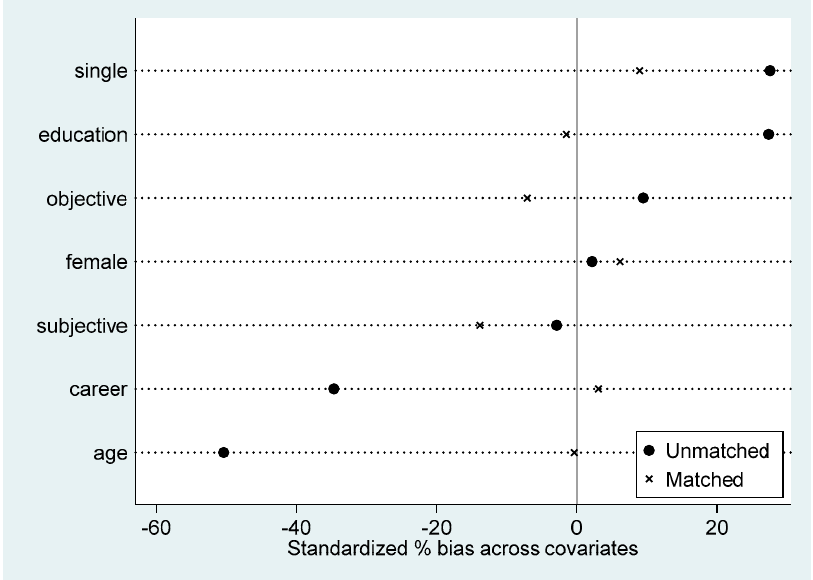
Figure A2. Standardized bias of each